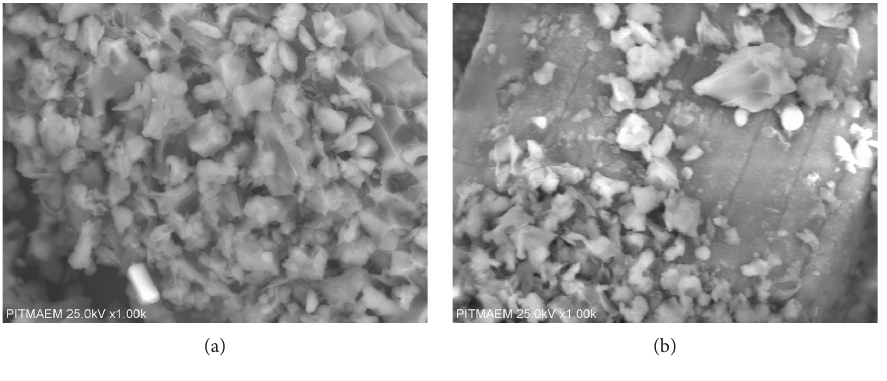
Figure 12: SEM image of PR leaves.